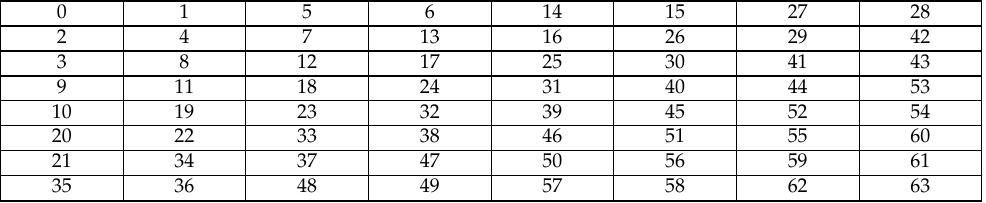
Table A3. Zig-zag order. Values in an MCU will be translated to a vector according to this order.